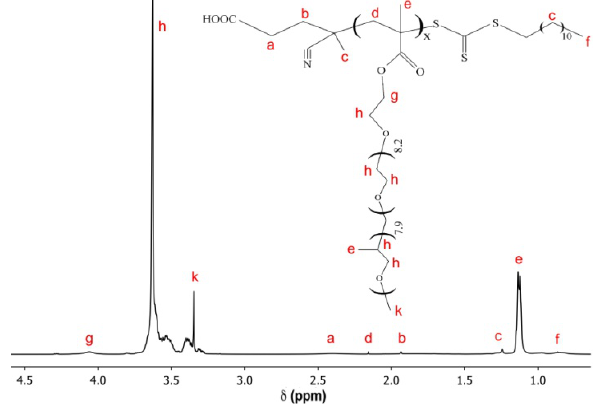
Figure 2. 1 H NMR spectra of polyOPG 8 OEG 8 MA.